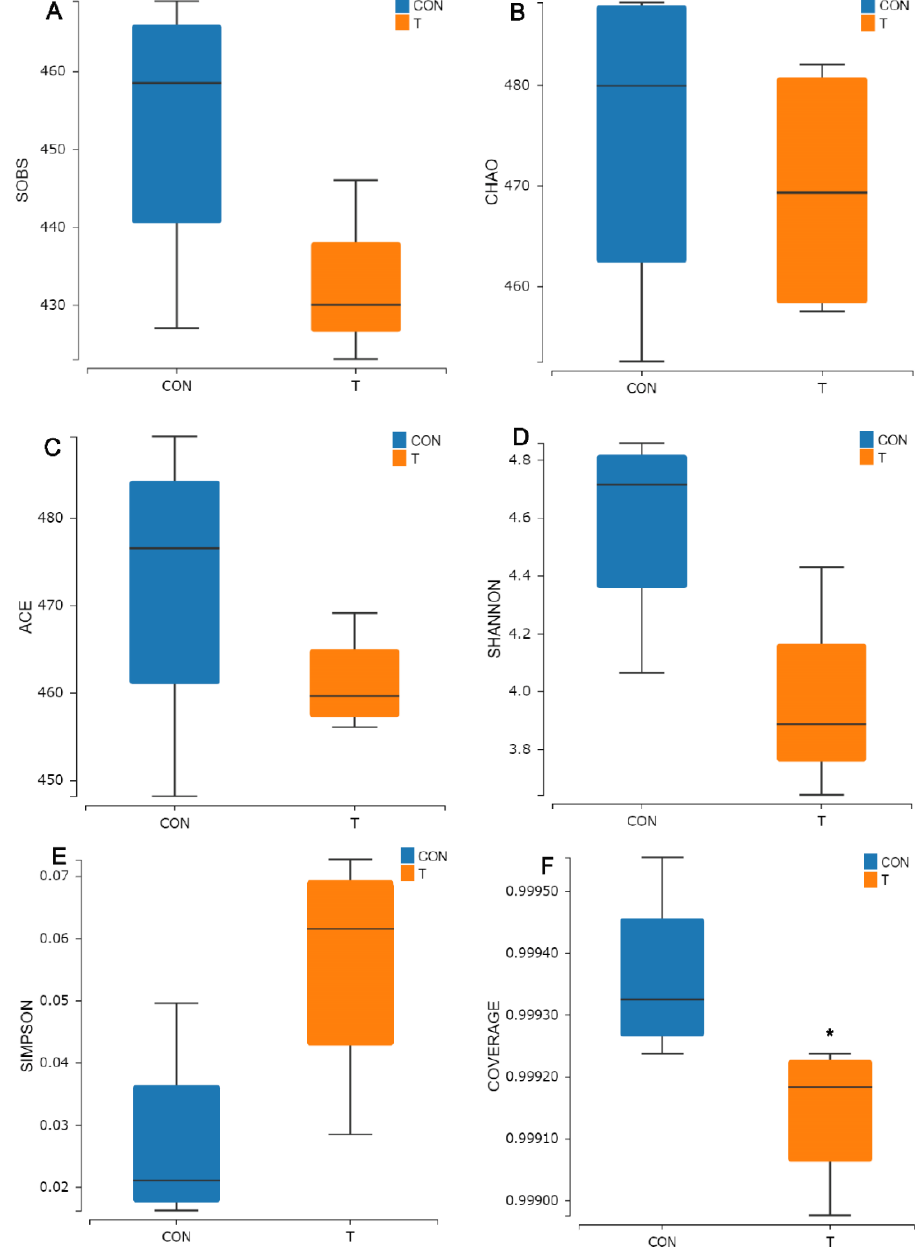
Figure 8. Comparison of ALE on α diversity indexes of intestinal microbial in mice. ( A ) Bacterial community richness index (SOBS); ( B ) Bacterial community richness index (CHAO); ( C ) Bacterial community richness index (ACE); ( D ) Bacterial community diversity index (SHANNON); ( E ) Bacterial community diversity index (SIMPSON); ( F ) Bacterial community diversity index (COVERAGE). * indicates significant difference between groups ( p < 0.05), and no * indicates no significant difference ( p > 0.05).